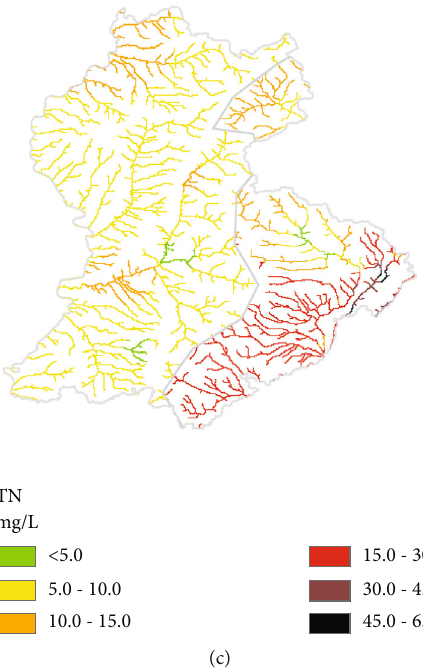
-N (b), and TN (c) in surface water on the eastern Loess Plateau. 3